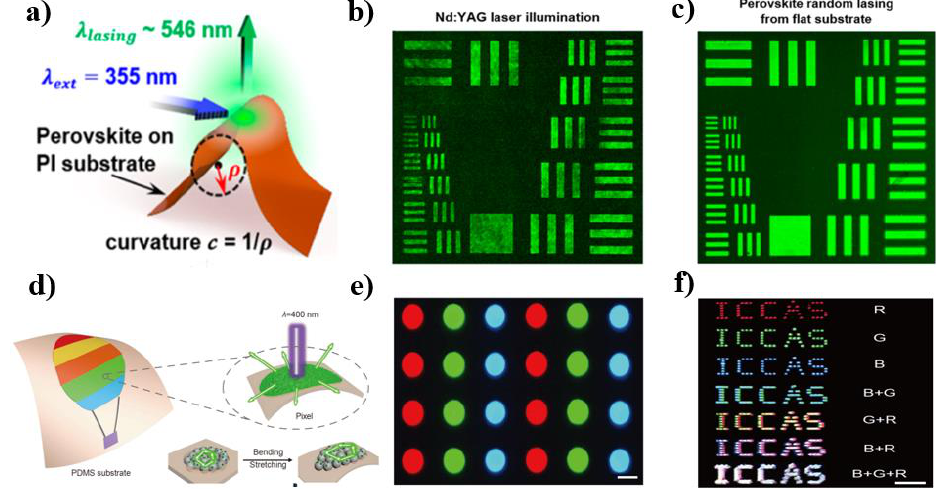
Figure 5. ( a ) Schematic illustration of excitation and emission of a flexible perovskite film laser under bending conditions. Optical imaging of Air Force resolution test chart via ( b ) Nd:YAG laser and ( c ) perovskite RL from the flat substrate. The images ( a – c ) adapted with permission from Ref. [84]; Copyright 2019 American Chemical Society. ( d ) Design principle of the flexible laser display based on RLs. ( e ) Fluorescence microscopy images of the periodic RGB emissive arrays under UV light radiation. ( f ) Far-field photograph of the “ICCAS” patterns of pixel arrays comprising different microlasers. The images ( d – e ) were adapted with permission from Ref. [74]; Copyright 2021 Science China Press and Springer-Verlag GmbH Germany, part of Springer